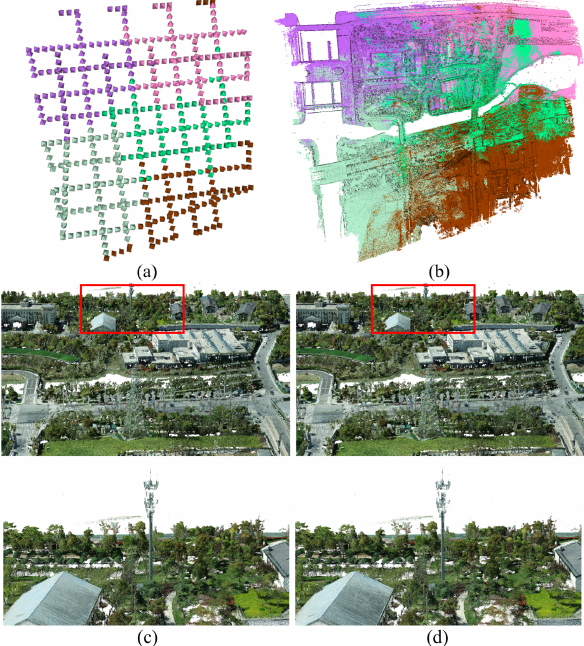
Figure 4. ( a ) Camera views of case “B5 West” divided into 5 clusters. ( b ) The final fused point cloud with points from different clusters visualized in different colors. ( c ) The fused point cloud without clustering. ( d ) The clustering-based point cloud fusion, with magnified rectangle regions to show almost no difference from ( c